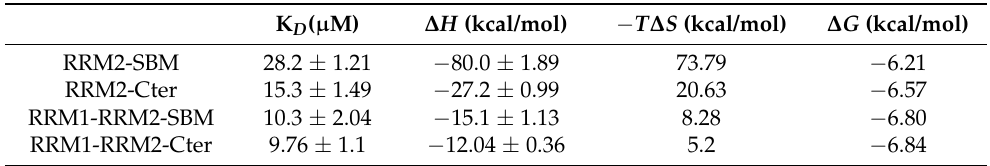
Table 2. Thermodynamic parameters of the interactions between the human La polypeptides and IRES-HCV domain